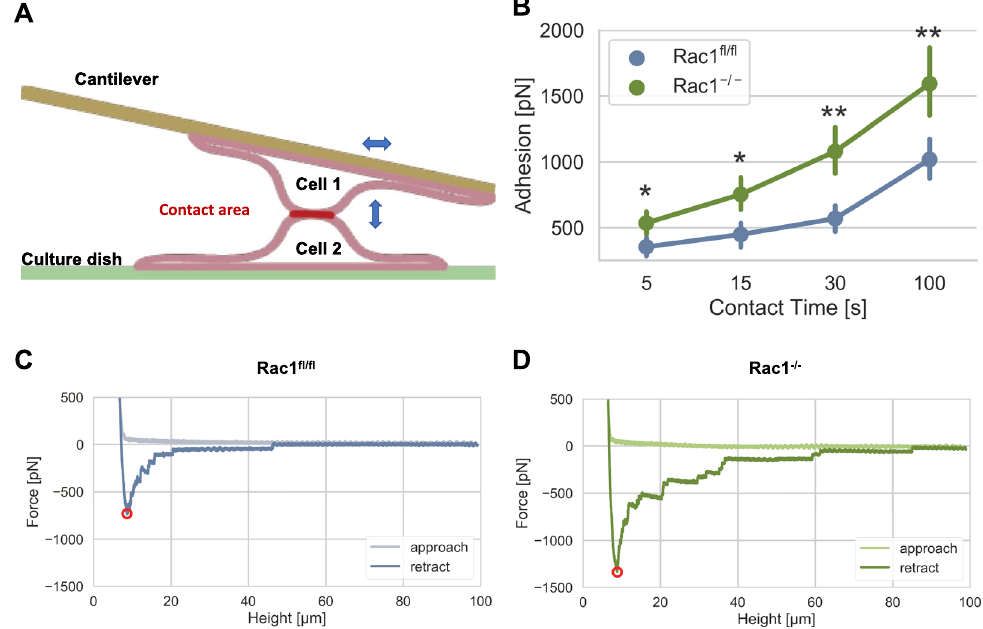
Figure 6. Rac1 knockout impacts on cell-cell adhesion strength using atomic force microscopy (AFM). ( A ) Schematic setup of the AFM measurement with cantilevers carrying a cell, which is pressed with 0.5 nN onto a single adherent cell of the same cell type. ( B ) Cell-cell adhesion forces between two cells of the same cell type of Rac1 − / − and Rac1 fl/fl cells. For each contact time and cell type, between 8–25 cells were analyzed. Representative force-height curves at 100 s cell-cell adhesion time of Rac1 fl/fl control cells ( C ) and Rac1 − / − cells are presented ( D ). * p < 0.05 and ** p <